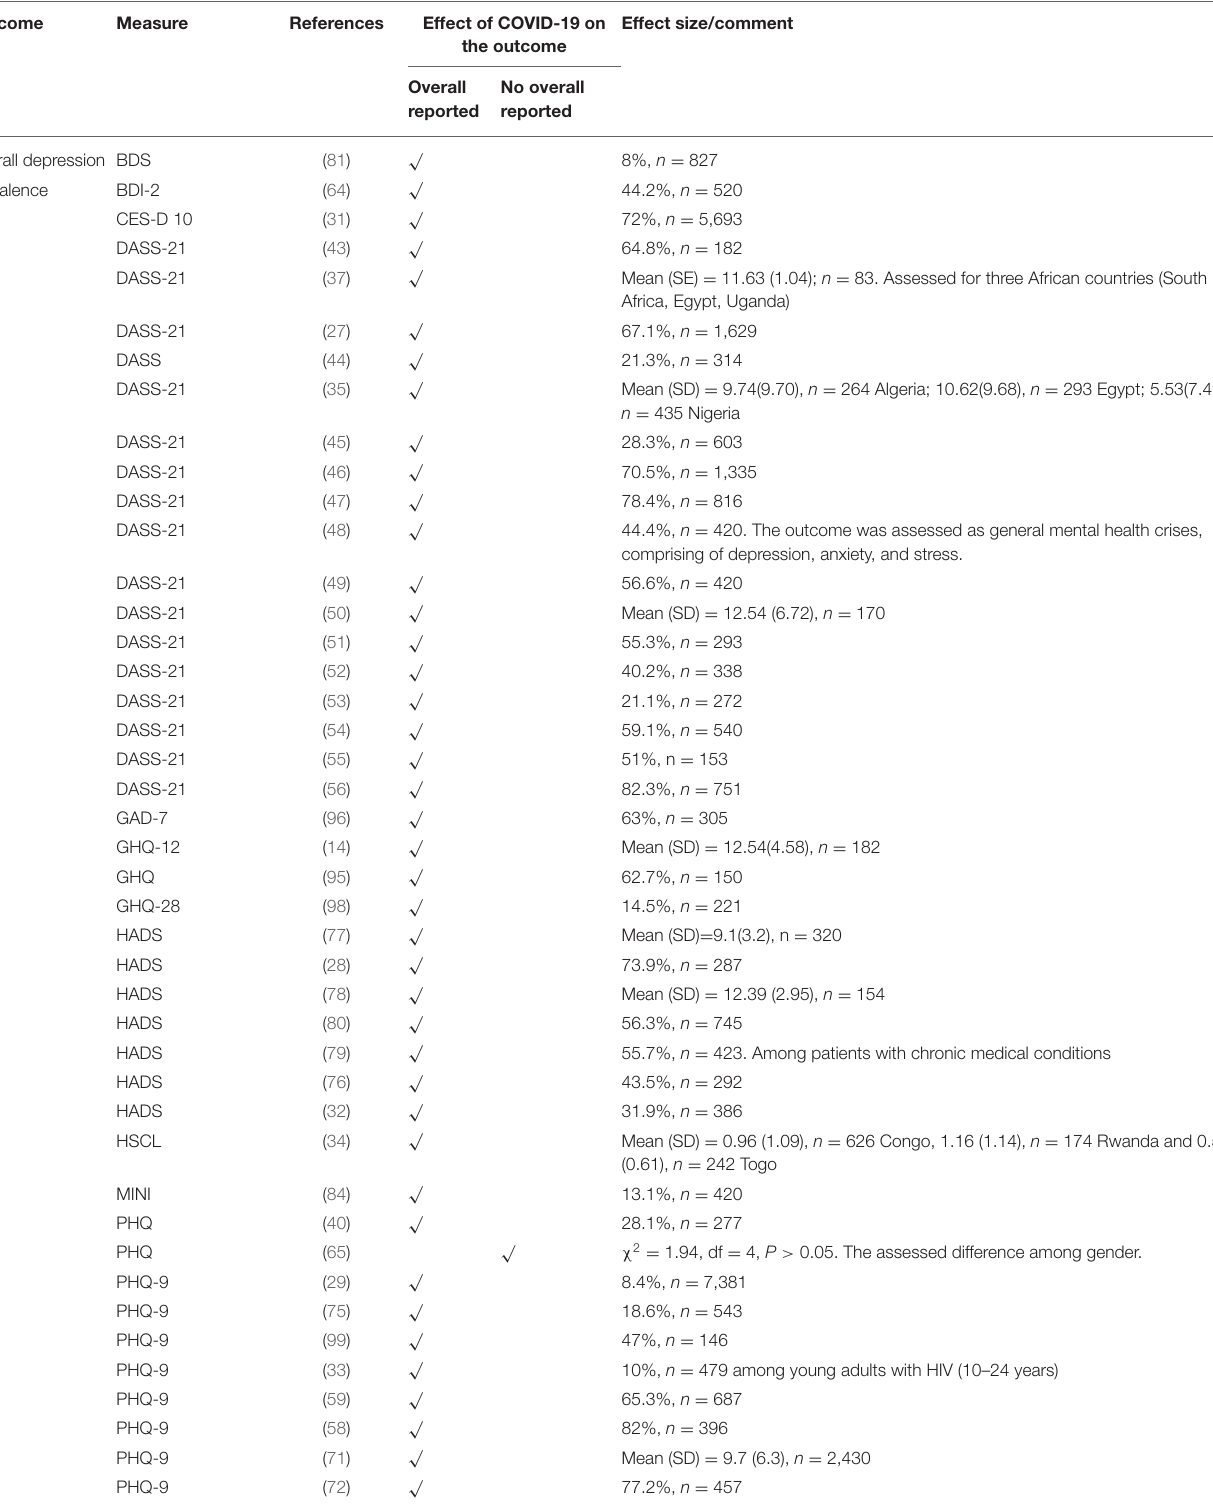
TABLE 2 | Depression-related COVID-19 effect in